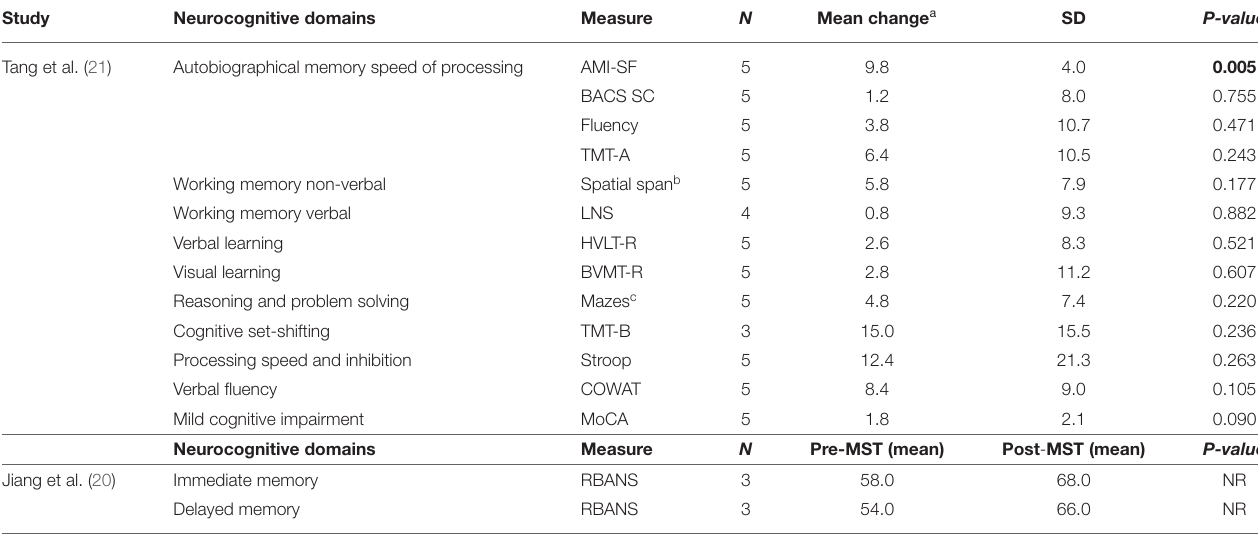
TABLE 3 | Neurocognitive adverse events after MST.